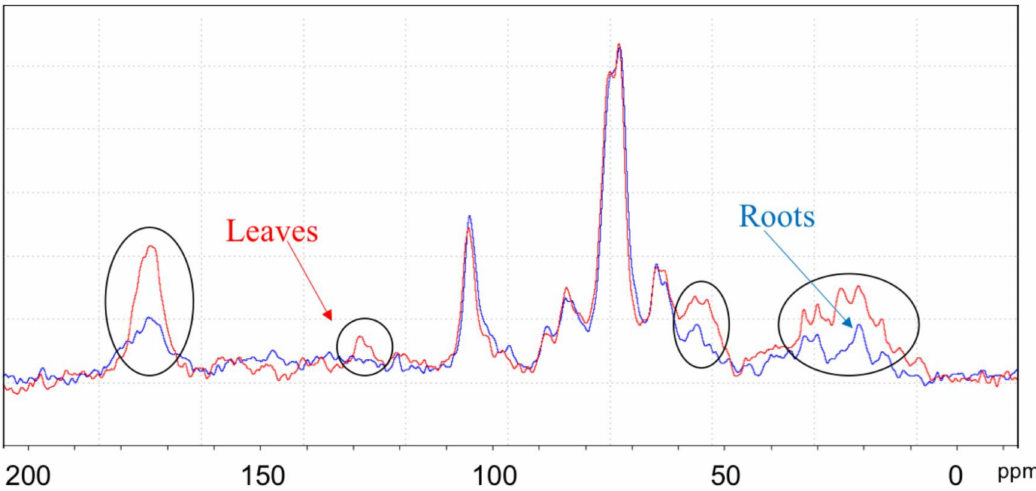
Figure 6. 13 C MAS NMR spectra of leaves (red) and roots (blue) derived from plants treated with high AA309 (=4.2 mg/kg N) dosage (MASr 25 kHz, 298 K). Ellipsis highlight the resonances that are increased in leaves with respect to roots; spectra are normalized on carbohydrate content.